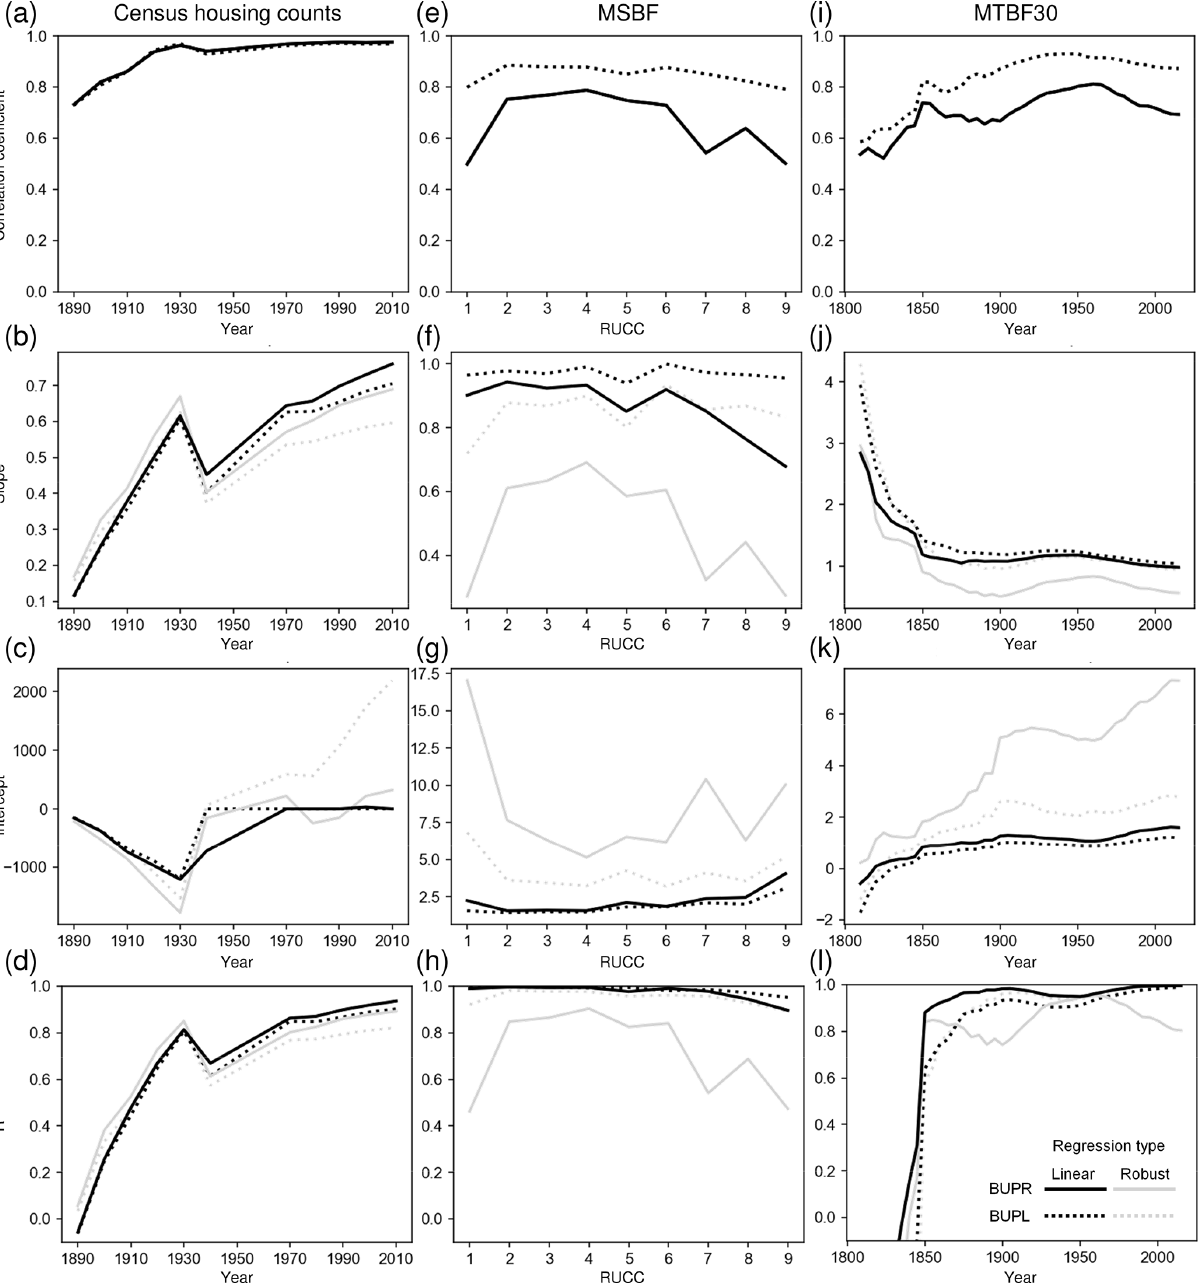
Figure G1. Regression and correlation results of BUPR and BUPL counts against the three validation datasets: (a) – (d) against census housing units within historical county boundaries, (e) – (h) against MSBF data across the rural–urban continuum (i.e. 2013 USDA RUCCs at the county level), and (i) – (l) against MTBF30 within grid cells. Larger differences between linear and robust regression coefficients indicate the presence of larger numbers of outliers (e.g. planned communities,